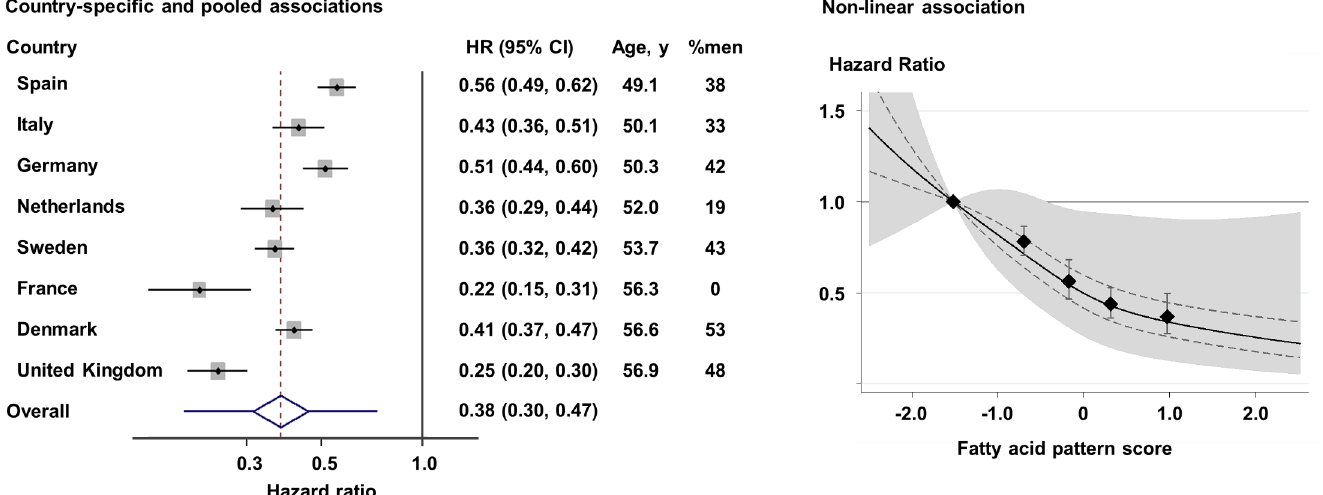
Fig 2. Prospective associations of the fatty acid pattern score with incident diabetes in 8 countries: EPIC-InterAct ( n = 27,296). Left: Hazard ratios (HRs) per country-specific range of 10th to 90th percentiles( p for heterogeneity by age and sex = 0.005 and 0.02, respectively), and pooledby random-effects meta-analysis. The diamondand error bars of the pooledestimate represent the 95% confidenceintervaland predictedinterval(0.20 to 0.74), respectively. Right: HR based on quintiles and restricted cubic spline( p non-linearity= 0.001) (solidline). Error bars in both panels,and dotted lines in the right panel, indicatethe 95% confidenceintervals of HRs, and the shadedarea in the right panel is the predicted interval. All analysesadjustedfor covariatesas in the most adjusted model in Table 2.